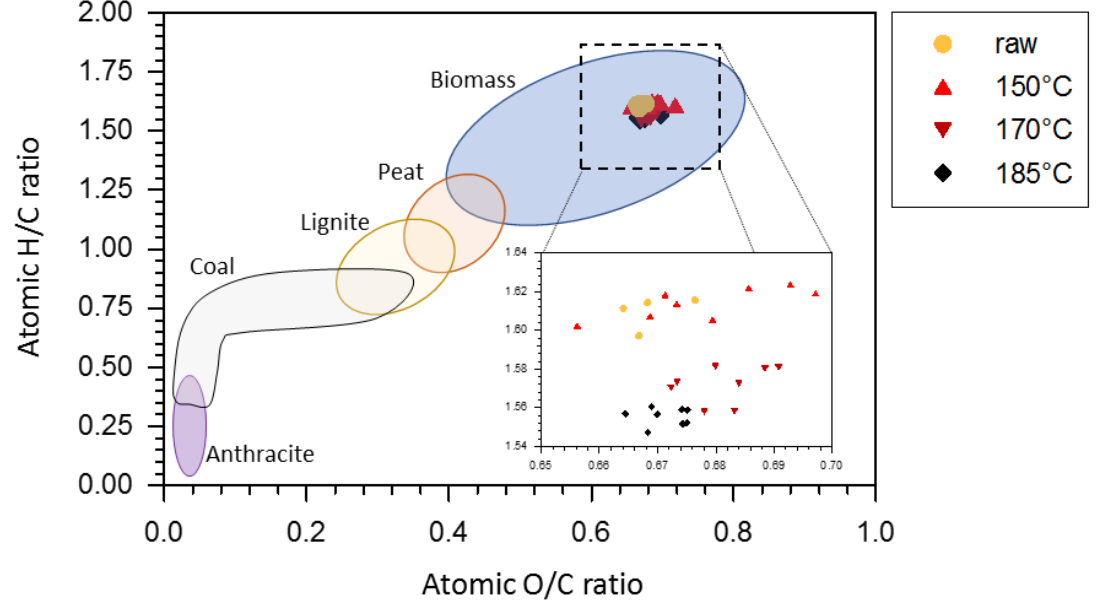
Figure 1. Van Krevelen diagram for the short-rotation coppice (SRC) biomass in comparison to different carbonized materials [19]. The inset shows the depletion of hydrogen and oxygen for the different intensities of the hydrothermal treatment. Table 2. Elements and trace elements detected in the raw material and the thermally treated material (mean ± standard deviation (coefficient of variation [%])). Different letters indicate significant differences of p < 0.05 between the datasets.